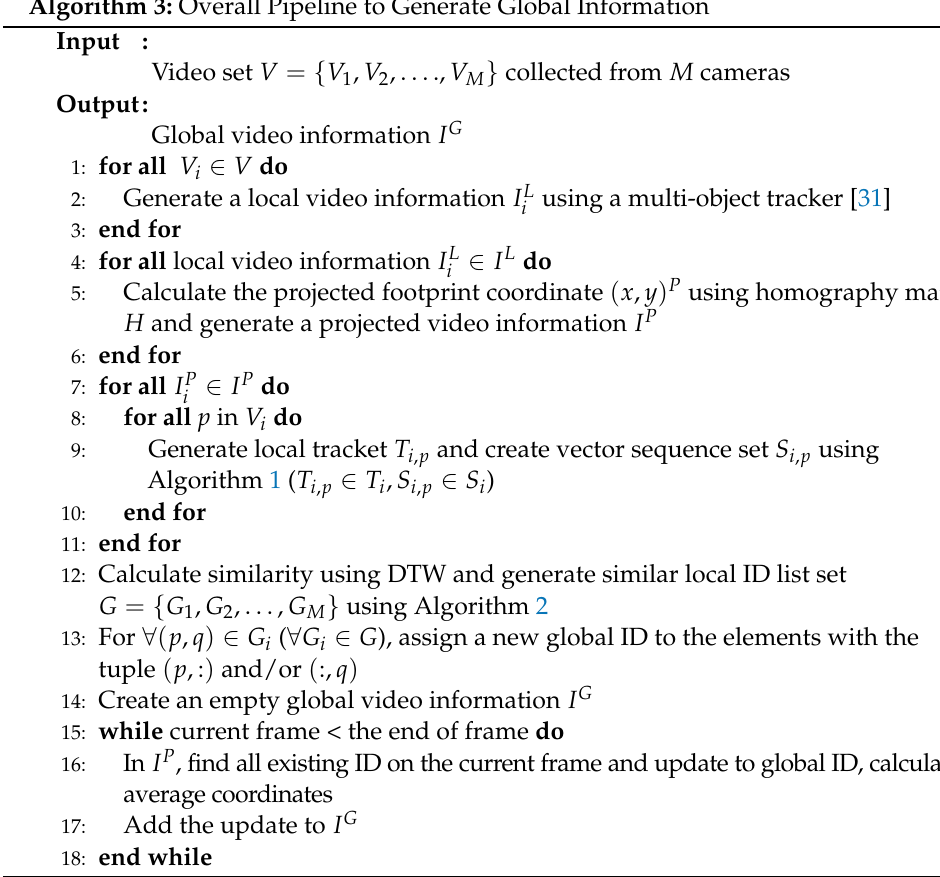
Algorithm 3: Overall Pipeline to Generate Global